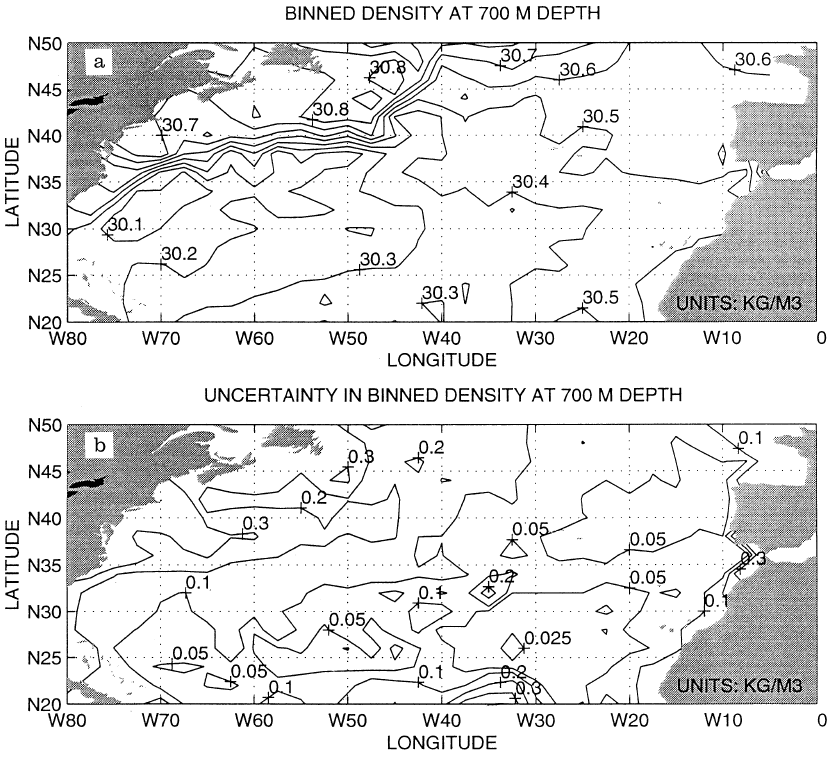
Fig. 12. a Density field (kg.m ) 3 ) binned onto the 2.5 (cid:176) longitude (cid:180) 2 (cid:176) latitude grid at 700 m depth. b Uncertainty (kg.m ) 3 ) in the binned density field at 700